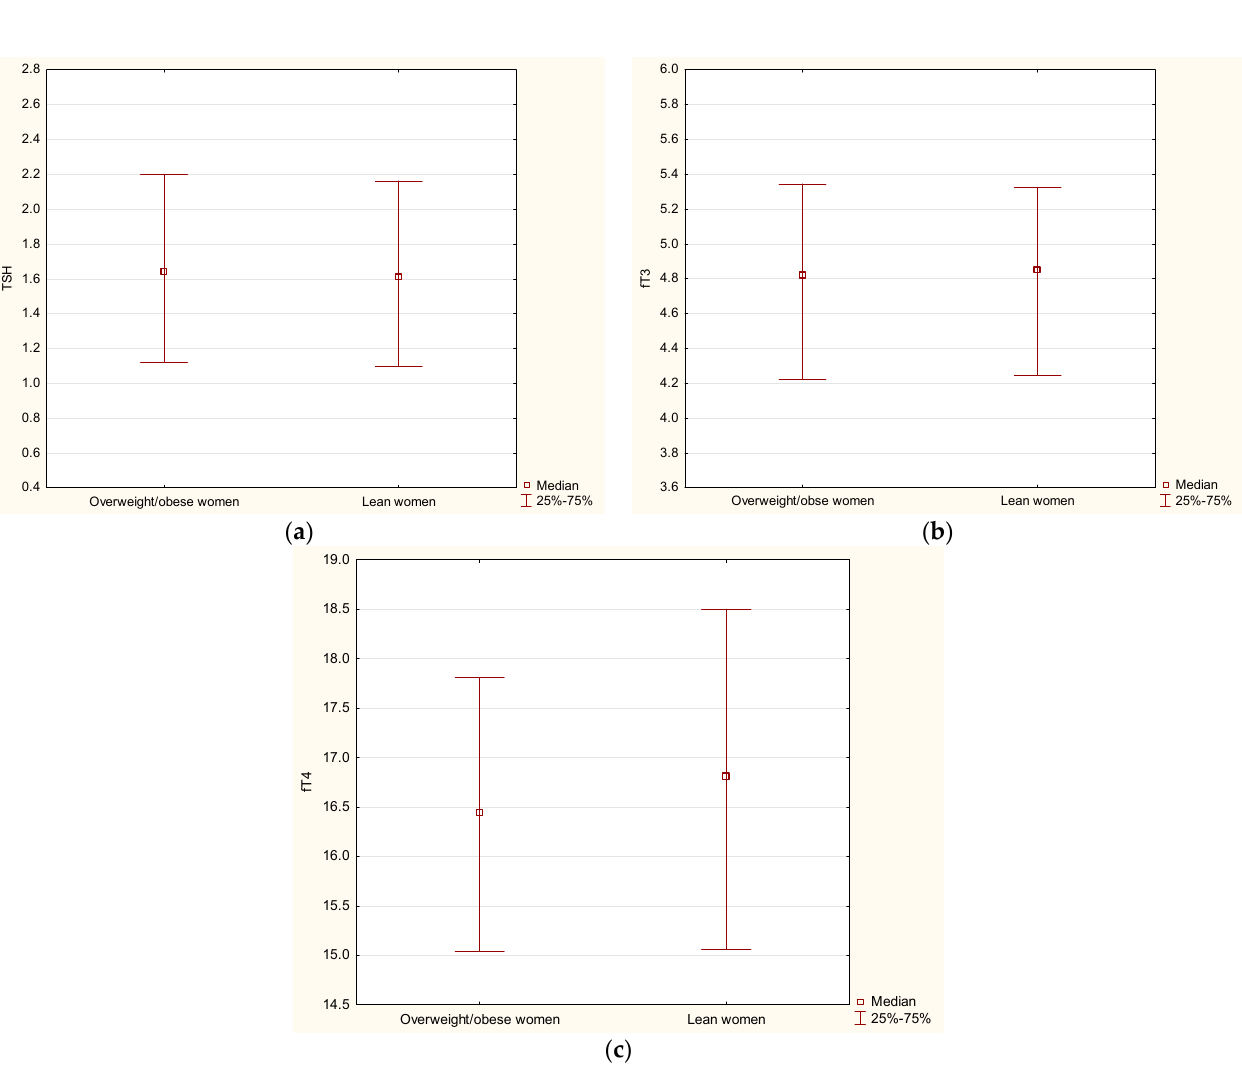
Table 4. Relationships between serum TSH and fT3 concentrations and body composition parame- ters estimated with DXA in lean and overweight/obese men.